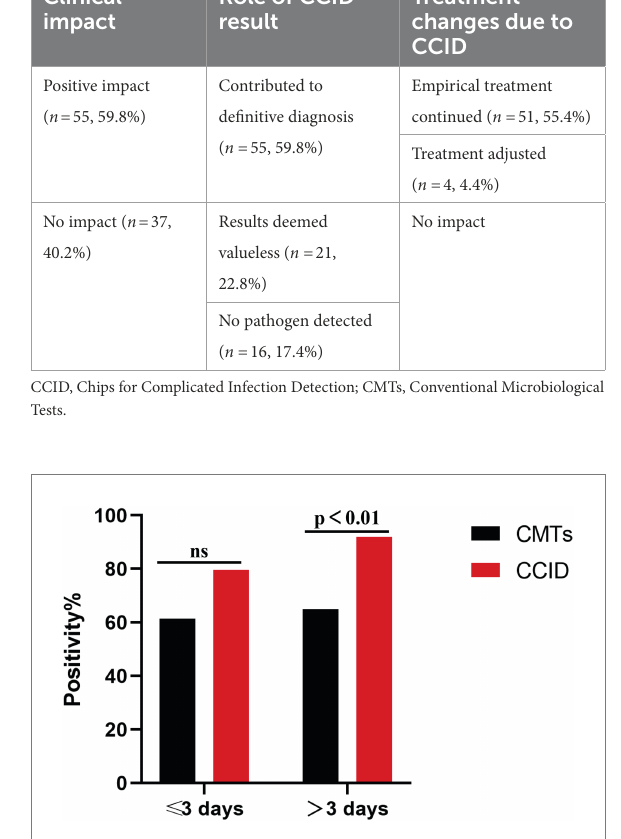
FIGURE 6 Percentage of positive samples in patients with pneumonia treated with antibiotics for ≤ 3 days and > 3 days. CCID, Chips for Complicated Infection Detection; CMTs, Conventional Microbiological Test; ns, no significance.